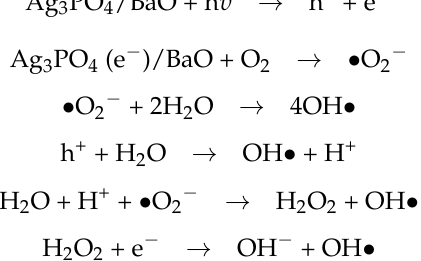
Weight of Catalyst Concentration Degradation Time (h) (g/L) of MB (ppm) (%)